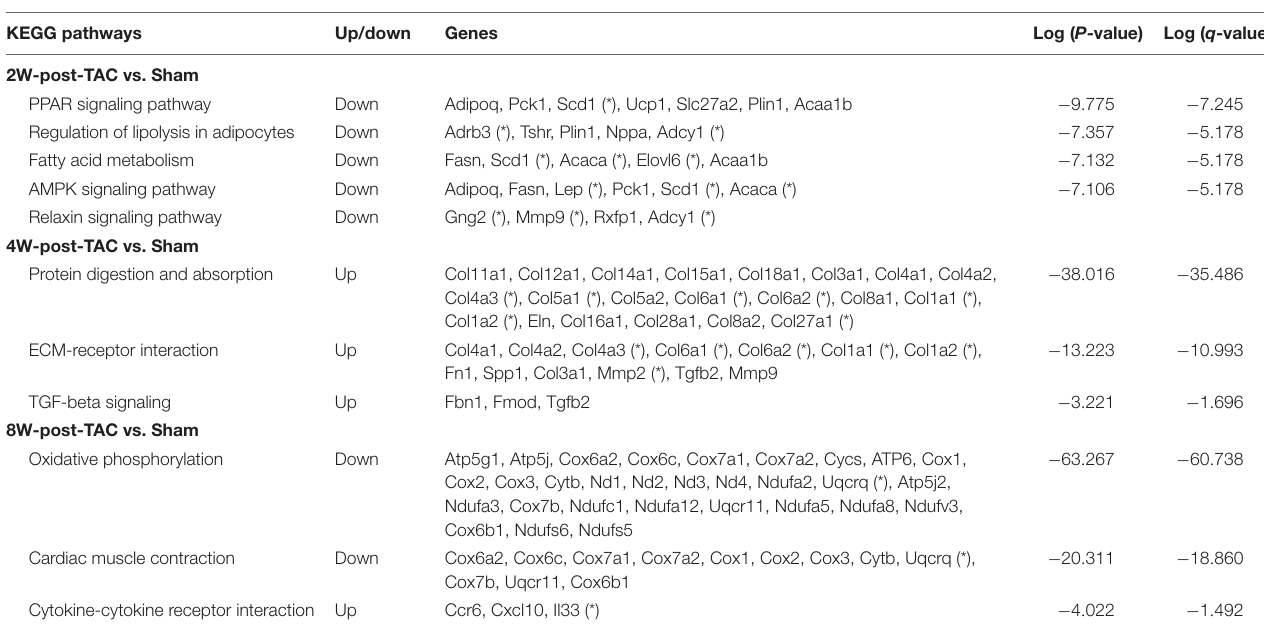
TABLE 2 | KEGG pathway enrichment of top 40 hub